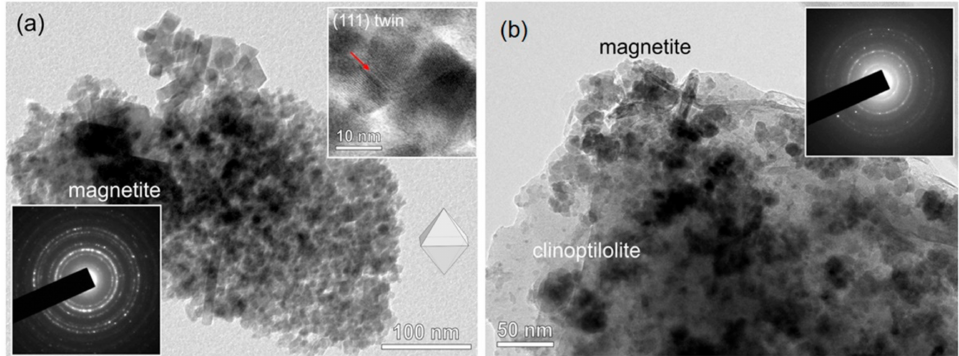
Figure 4. TEM image with SAED pattern of pure MAG ( a ) and MAG-CLI ( b )